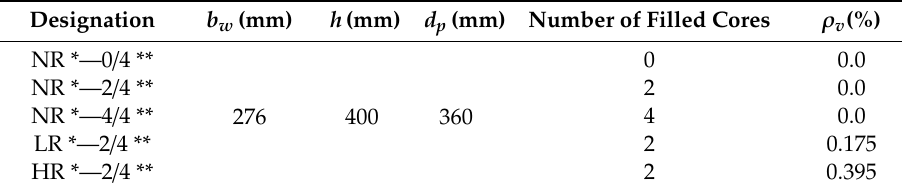
Table 2. Details of test specimen.